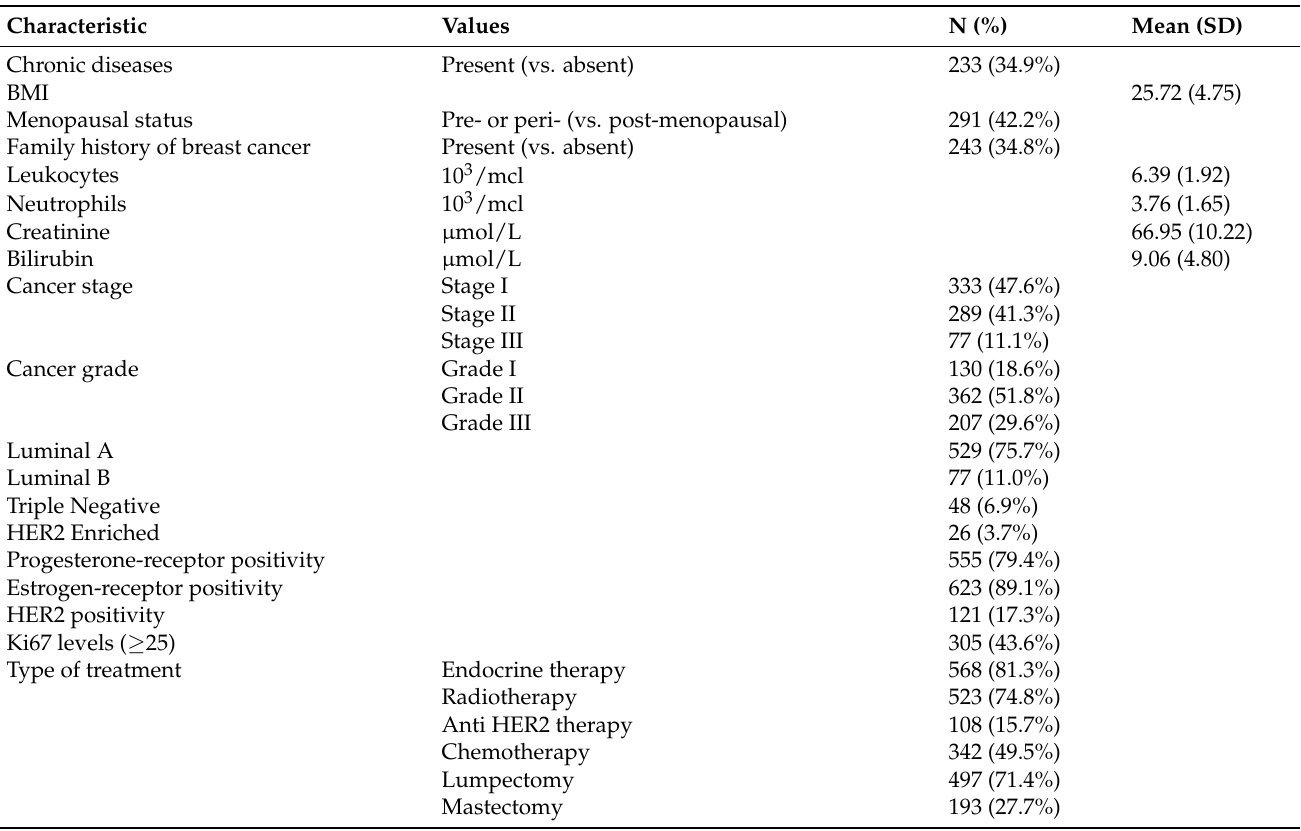
Table 2. Distribution of participant baseline general and disease-specific medical characteristics (N = 699).